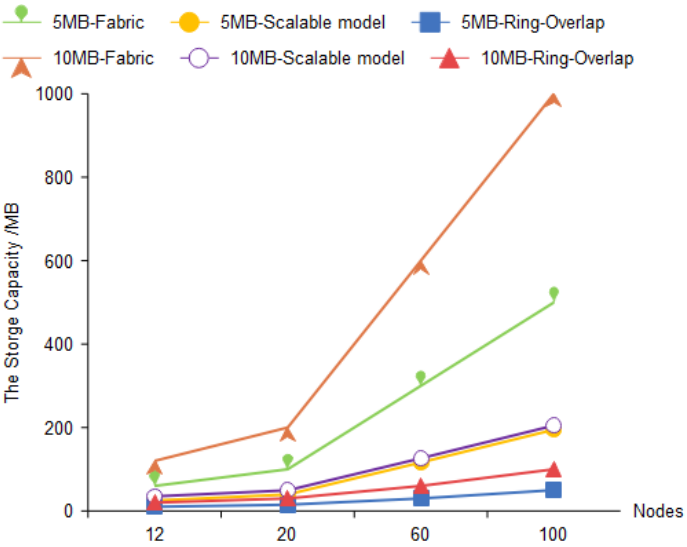
Figure 8. Storage space occupied by Ring-Overlap with Hyperledger Fabric and scalable model.